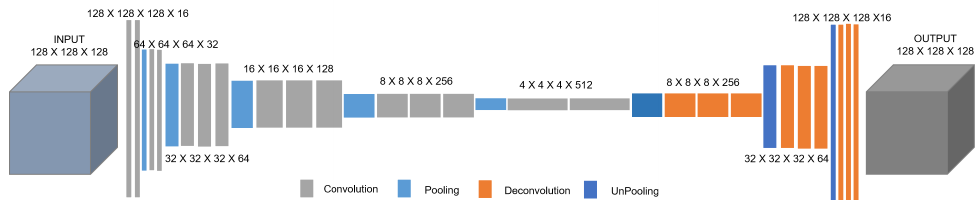
Figure 5. Architecture of FCN. We got FCN by modifying VGG16. We changed the input and output dimensions to 128 × 128 × 128 and 128 × 128 × 128, respectively, replaced the FC layers with the fully convolutional layers, and added the deconvolution layers and unpooling layers.